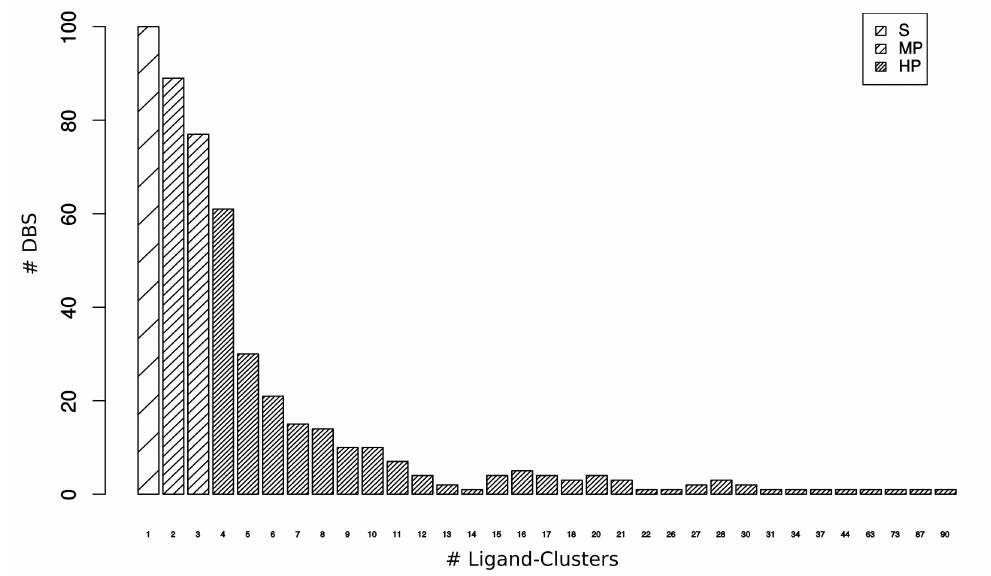
Figure 2. Number of DBS interacting with 1 to 90 Ligand–Clusters from the DBS4 dataset. Among the 481 DBS, 100 were selective (S), 166 were moderately promiscuous (MP), and 215 were highly promiscuous